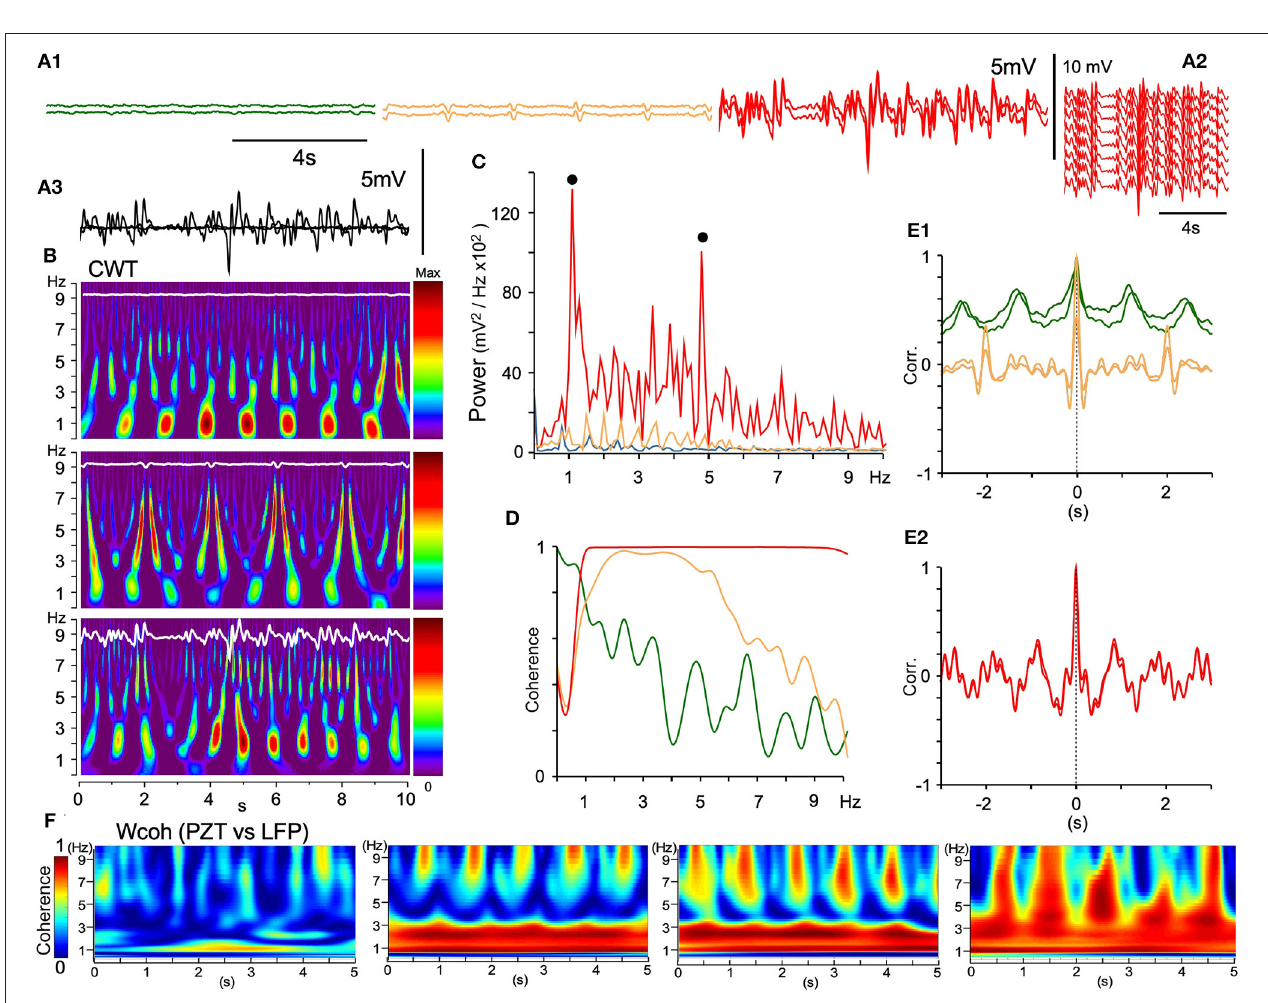
FIGURE 8 | lowest trace) obtained from original high-amplitude potentials in synchrony with every inspiration phase (middle traces) and PZT signals (gray in the upper trace) produce similar CWT structures. (A2) LP and PZT signals give different CWT profiles. Compared to PZT, the LP CWT profile has intense signals for larger frequencies ( > 5Hz) and very low signals for 1Hz frequencies. Note that amplitudes of LP signals are far larger than those shown in (A1) , and the VC ∼ ∼ high-amplitude signals synchronize with every second respiratory component of the PZT signals. Time-resolved coherence spectra (wavelet coherence; Wcoh) between PZT and LP signals show different profiles with either 1Hz or 1/ 3Hz dense bands (white arrows). (B) and (C) , CWT profiles (upper in B1,C1 ) and the ∼ ∼ ∼ corresponding VC LFPs (lower in B1,C1 ) recorded with a multiple silicon electrode. (B1) Two episodes of recordings from the same site temporally 5s apart. (B2) Power spectrum measurements of each episode over a period of 5s. (C1) Two simultaneous recordings from two sites spatially 300 µ m apart. (C2) Correlograms ∼ (Corr.) of each episode between adjacent LFPs (50 µ m apart). (D1) and (D2) Linear correlation between Corr. of two simultaneously-recorded LFPs according to the mean signal amplitudes (D1) and the distances between recording sites (D2) .